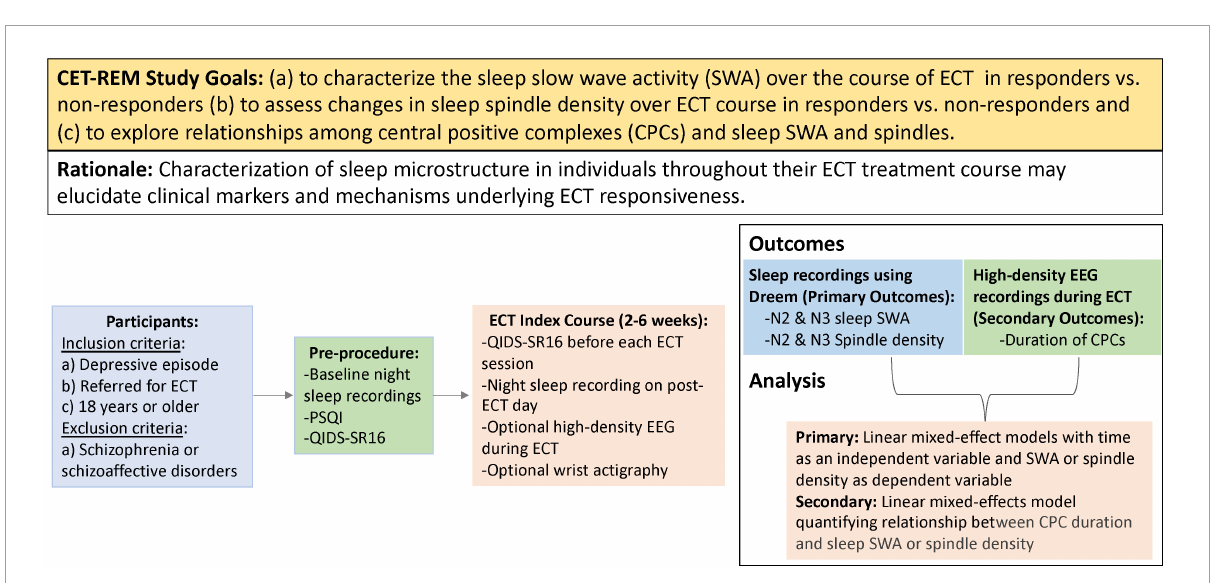
FIGURE3 PICOT (participants, intervention, control, outcomes, timing) summary of study design. This study will recruit adults requiring ECT treatment for a depressive episode. Participants will wear a Dreem headband at night to obtain sleep EEG recordings throughout the course of ECT. High-density EEG recordings will also be obtained during ECT sessions to assess central positive complexes (CPCs). The primary outcomes of CET-REM include characterization of slow wave activity and sleep spindle density throughout ECT